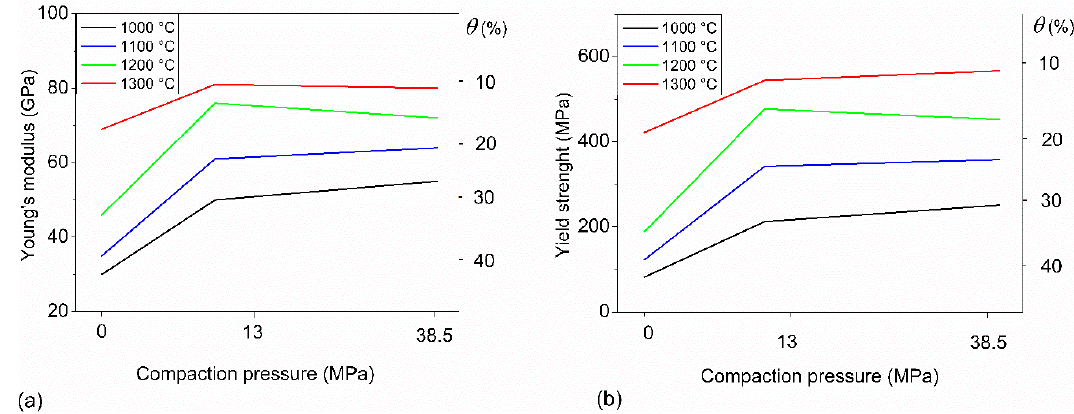
Figure 3. Experimental results of Young’s modulus ( a ) and yield strength ( b ), in terms of compaction pressure, for each sintering temperature. Values of total porosity, θ , are also included.